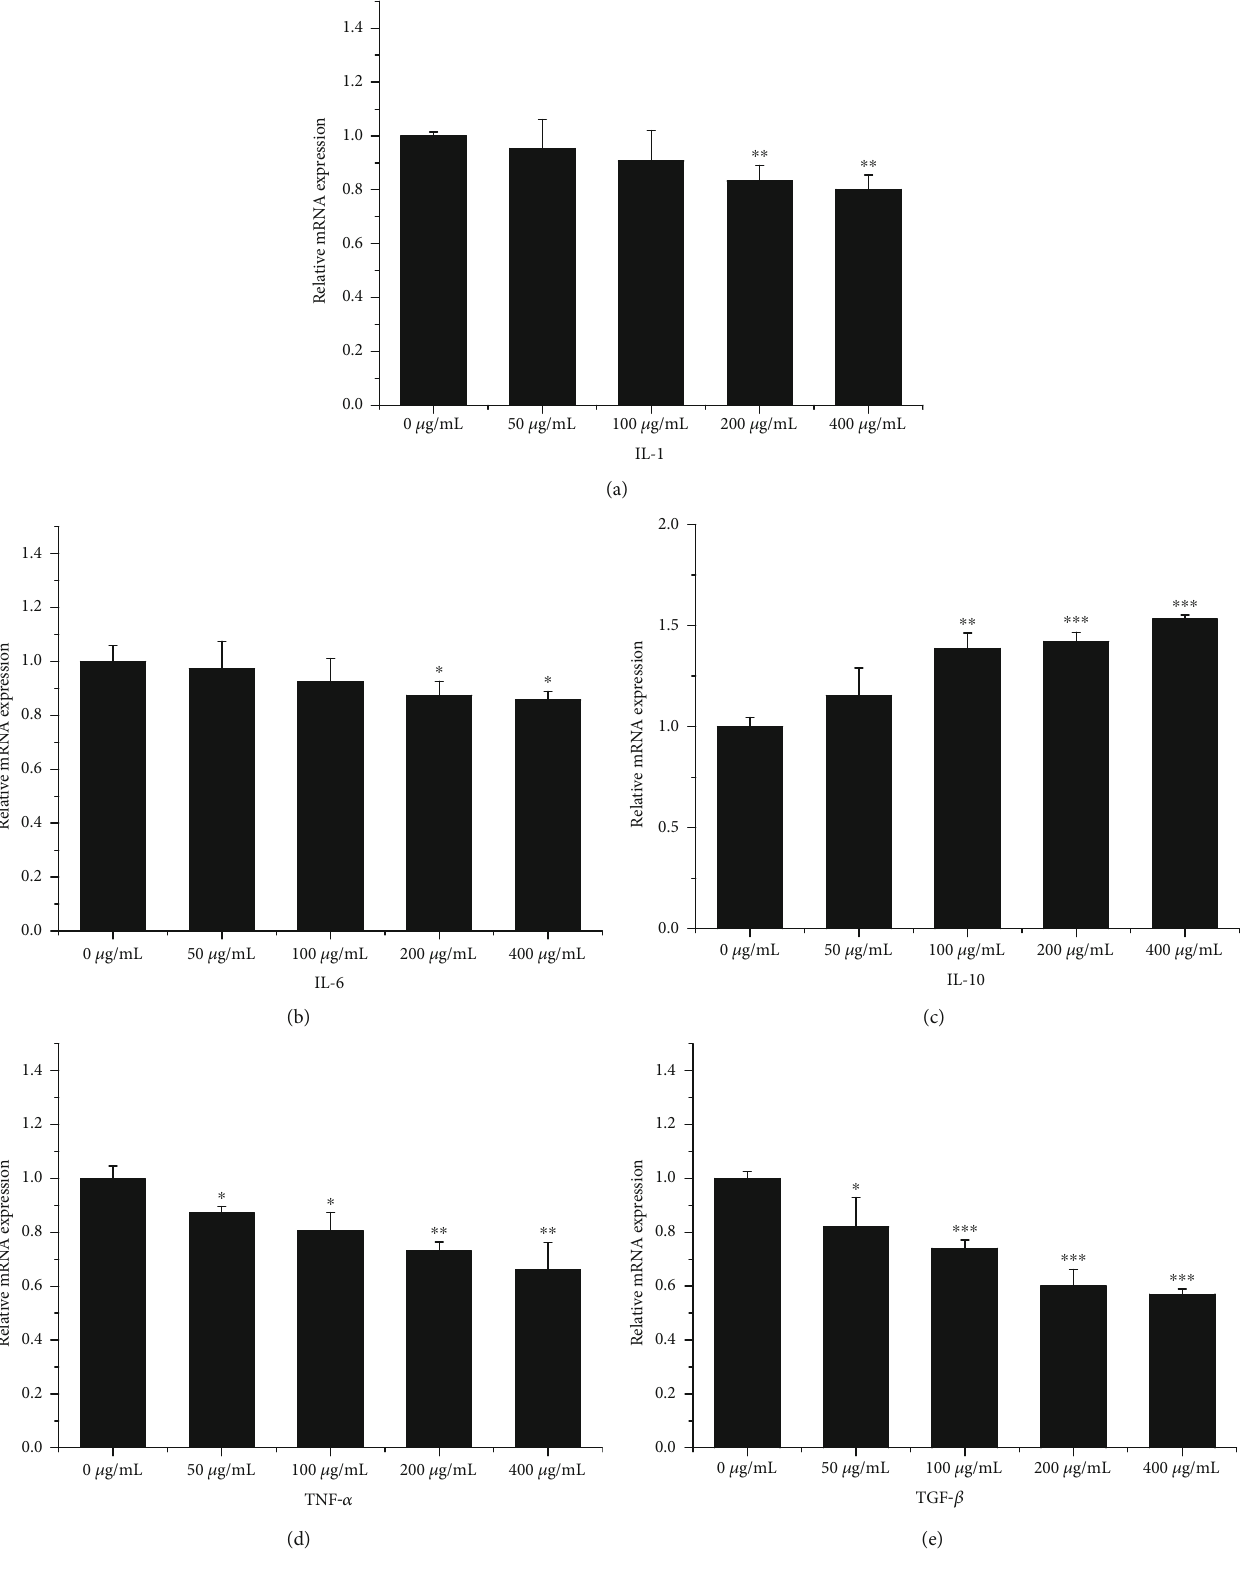
Figure 5: RT-PCR was used to detect the expression of cytokines in Eca109 cells: (a) IL-1; (b) IL-6; (c) IL-10; (d) TNF- α ; (e) TGF- β . Compared with the control group, ∗ p < 0 : 05 , ∗∗ p < 0 : 01 , and ∗∗∗ p < 0 : 001